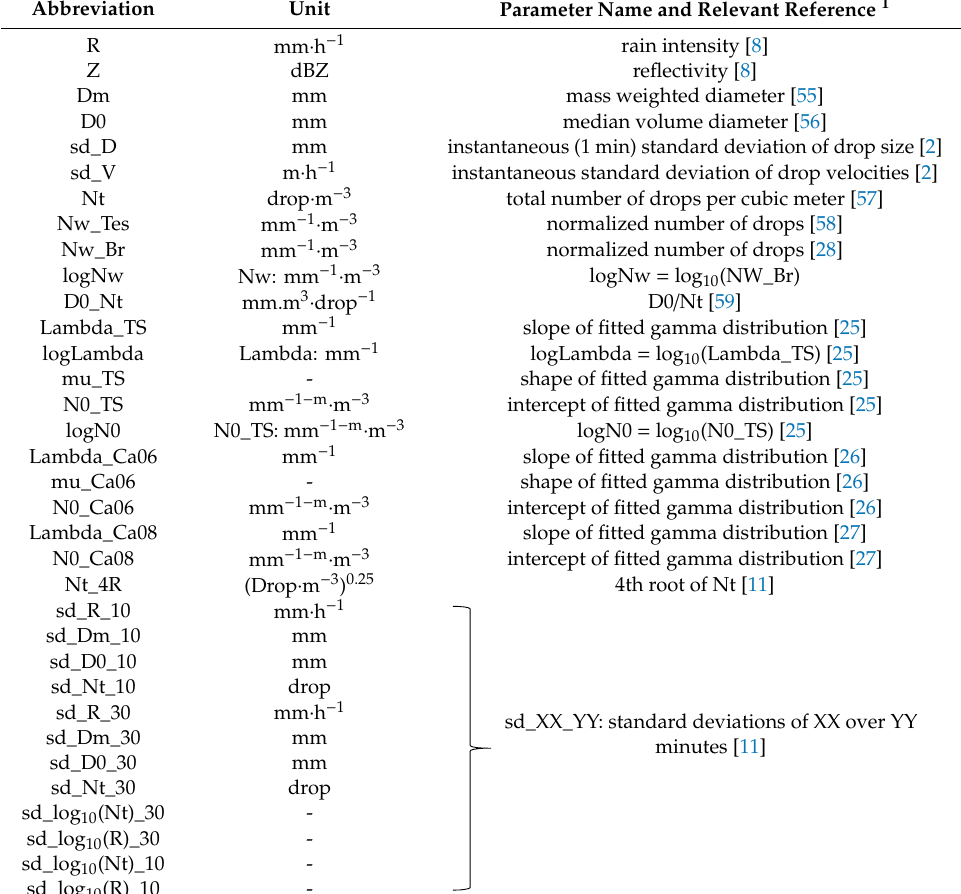
Table 2. Drop size distribution parameters as potential rain type classifiers.